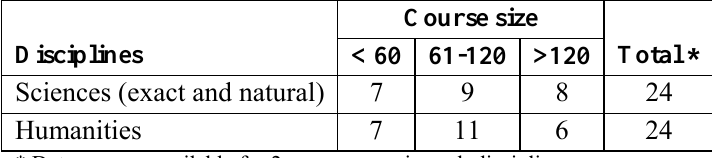
Distributions by Course Group Size – Number of Enrolled Students